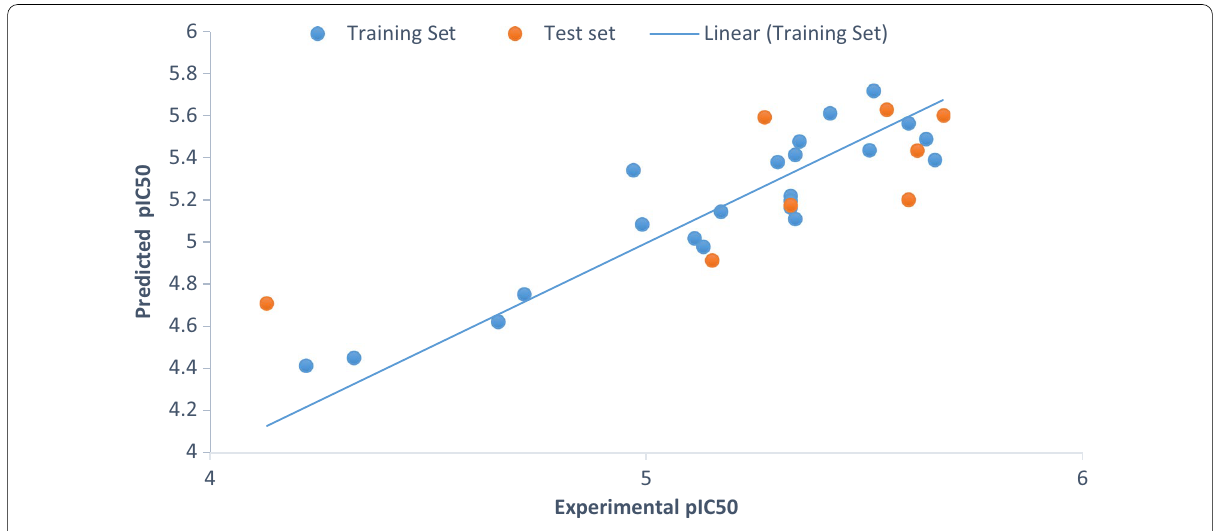
Fig. 1 Predicted pIC 50 versus experimental figures of the modelling and validation